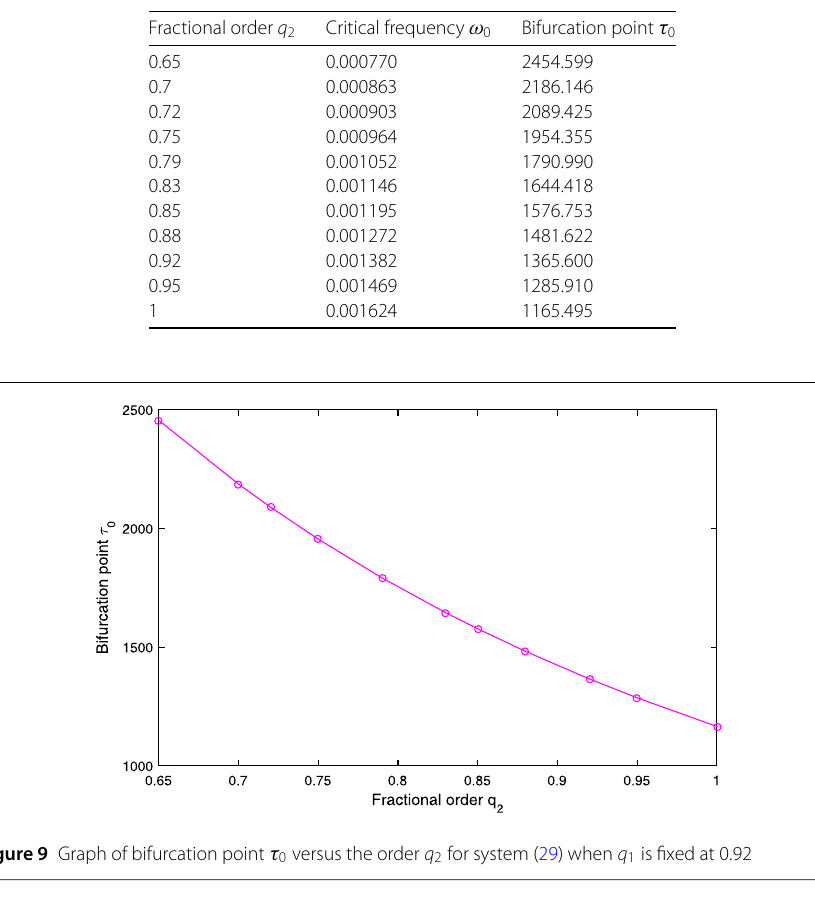
furcation point τ 0 as q 2 is varied. The computed values of ω 0 , τ 0 are listed in Table 3.